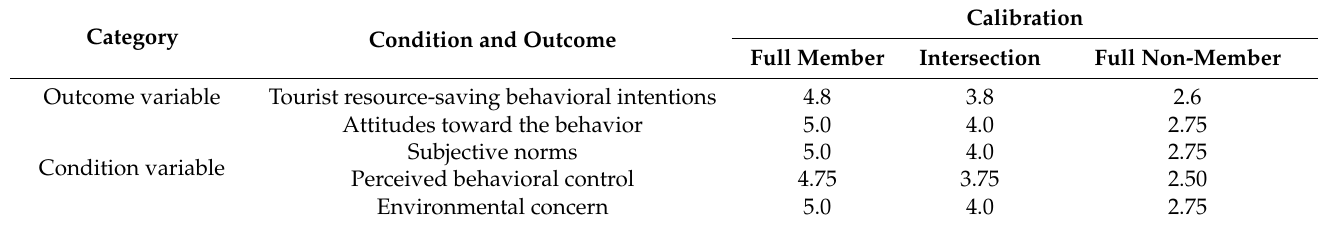
Table 9. Condition and outcome calibration in the model of tourist resource-saving behavioral